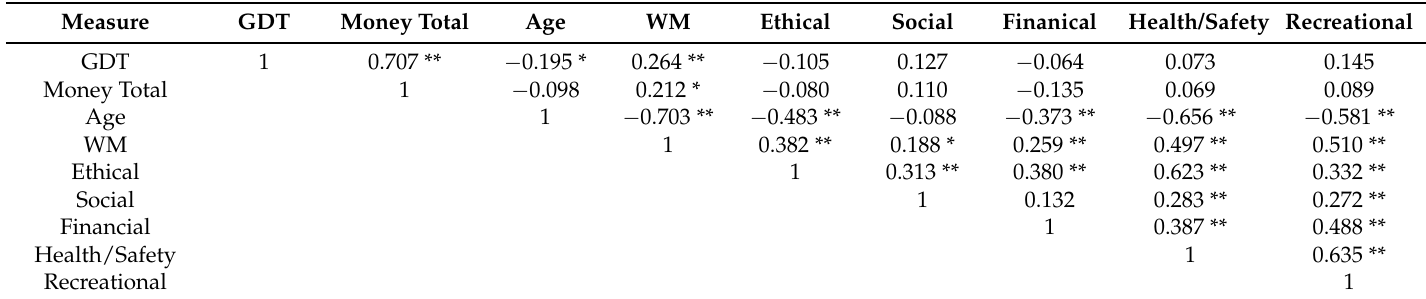
Table 6. Correlations between GDT, money total, age, working memory, and DOSPERT